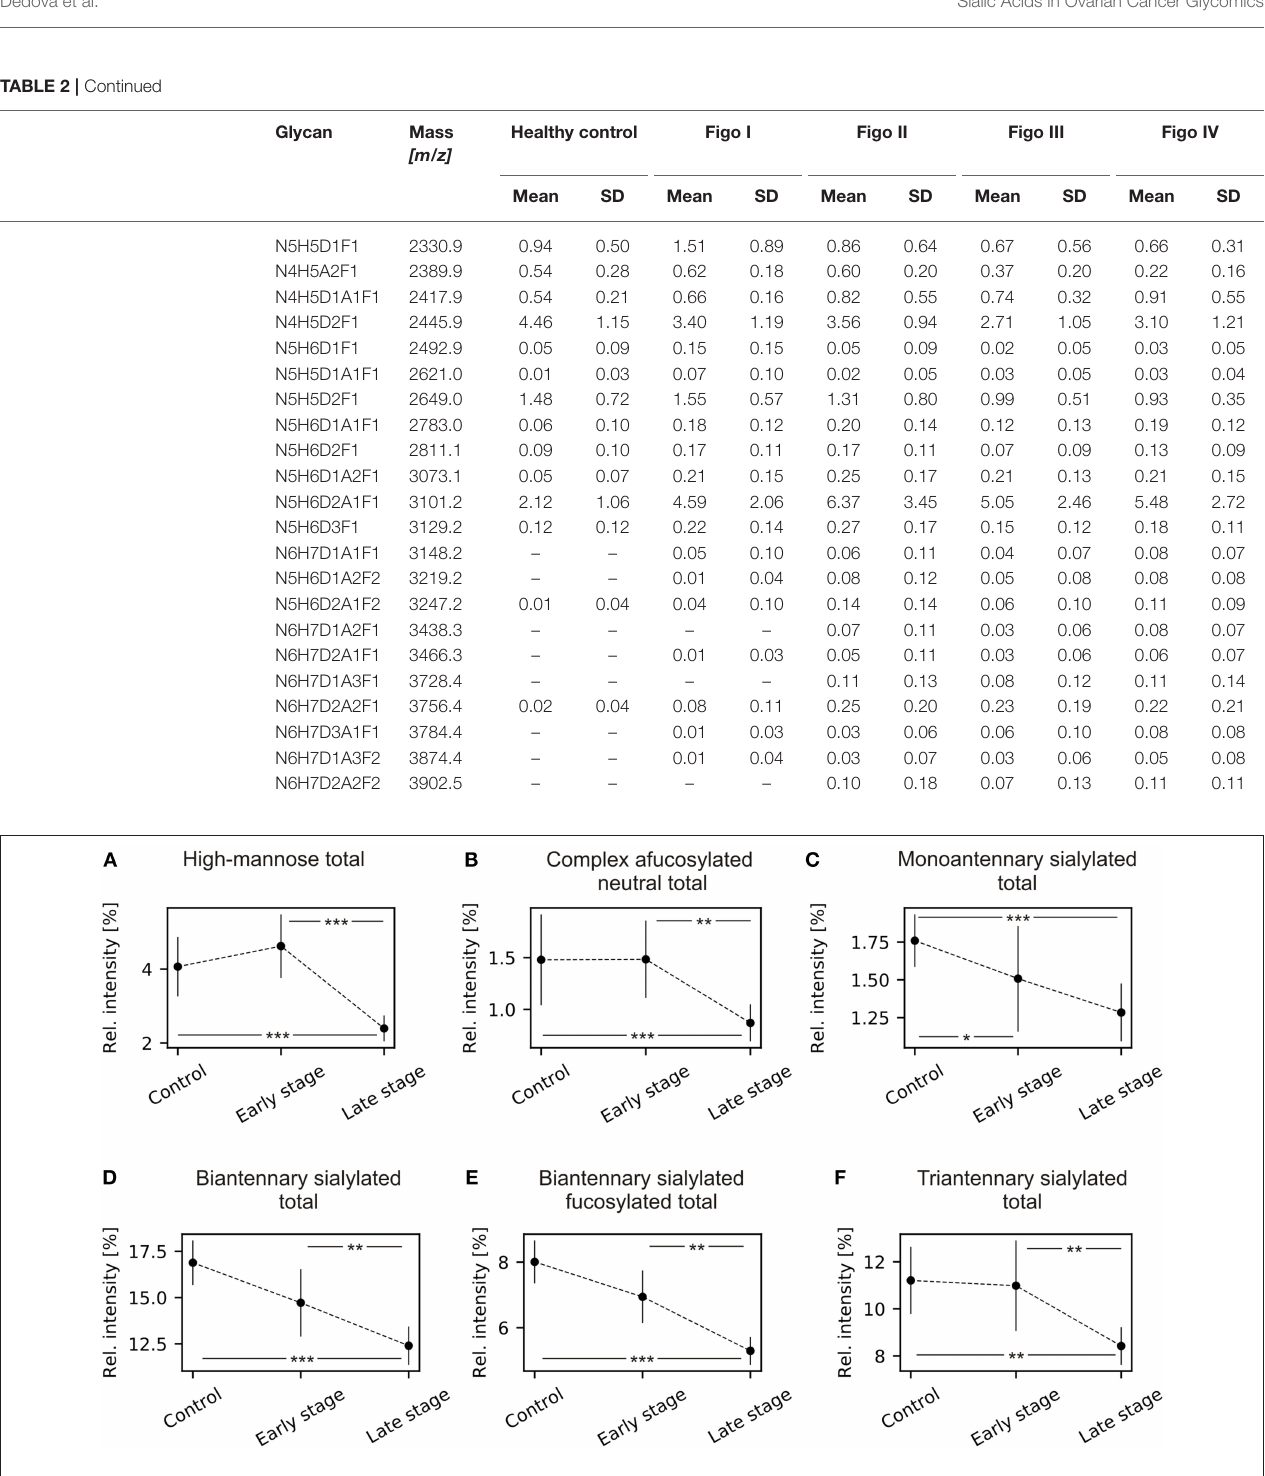
FIGURE 2 | Mean and 95% confidence intervals of N -glycans grouped by type, antennarity, sialylation, and fucosylation during ovarian cancer progression. (A) High-mannose type total; (B) complex type afucosylated neutral total; (C) monoantennary sialylated total; (D) biantennary complex total; (E) biantennary sialylated fucosylated total; (F) triantennary sialylated total. * p < 0.05, ** p < 0.01, *** p <